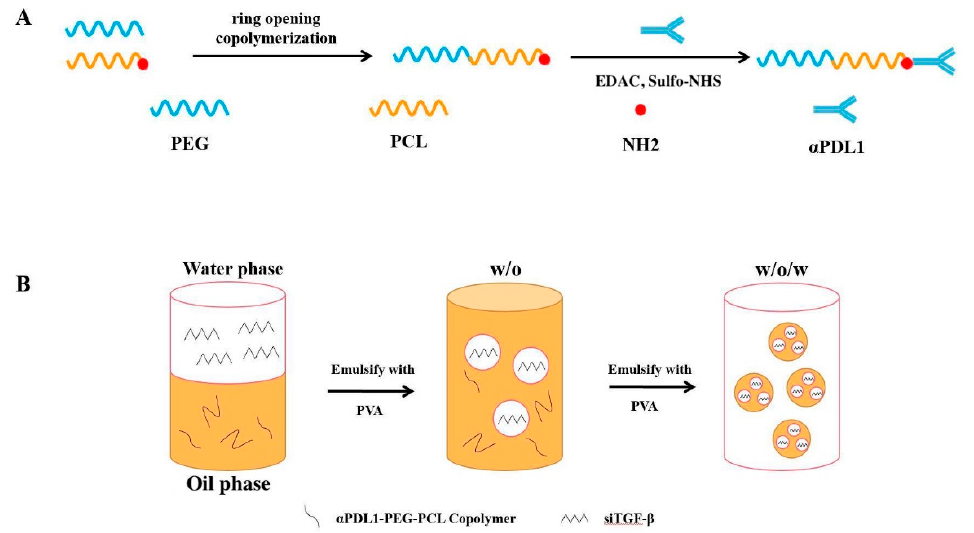
Figure 7. ( A ) Schematic illustration of the fabrication of α PDL1-conjugated PEG-PCL NPs. The NPs comprise a PCL core, a hydrophilic and stealth PEG shell on the surface of the core and a α PDL1 ligand coating layer. ( B ) Preparation of siTGF- β 1- α PDL1-PEG-PCL-NPs ( α PDL1, anti-programmed cell death-Ligand 1; NPs, nanoparticles; siTGF- β 1, Transforming Growth Factor- β 1 siRNA).